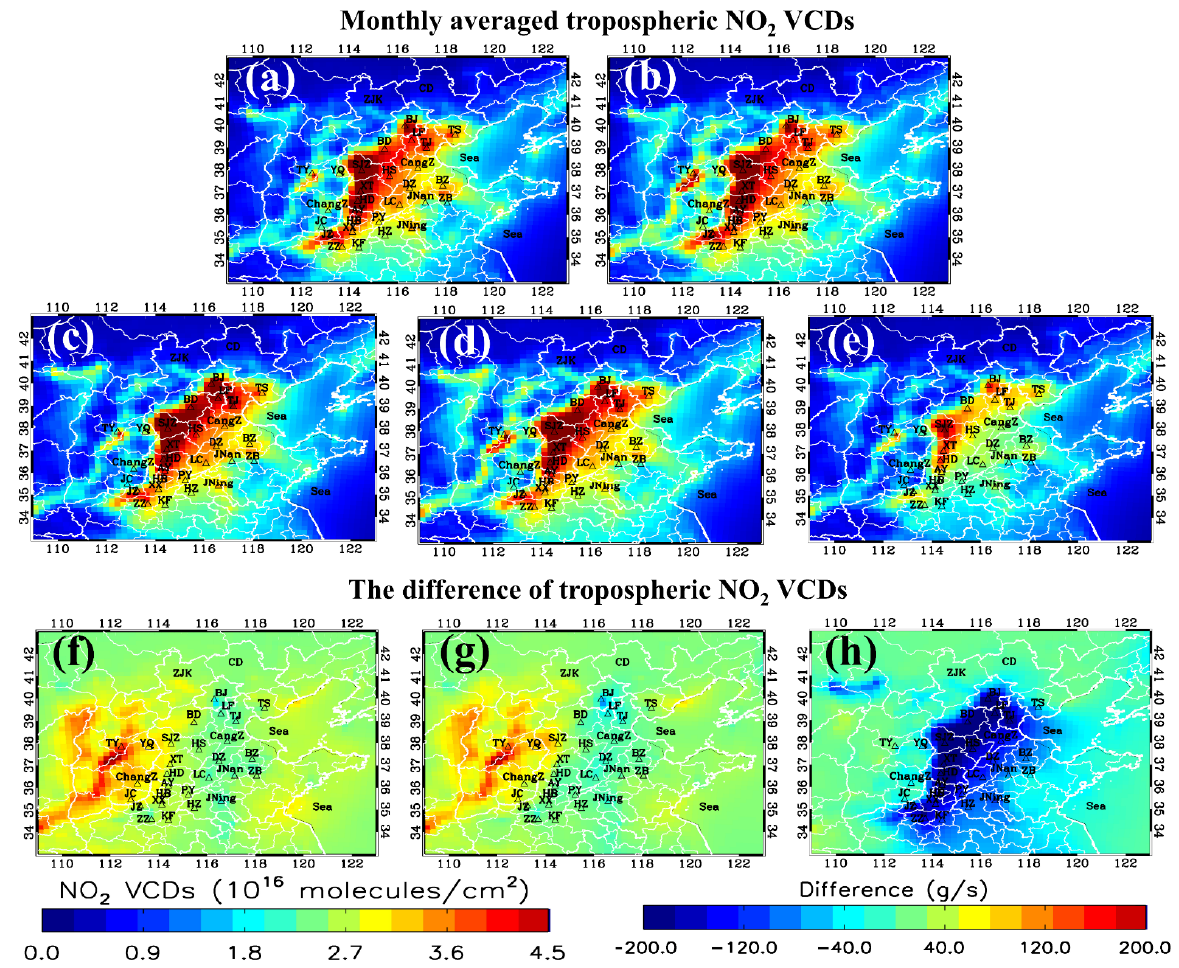
Figure 3. Four-month averaged tropospheric NO 2 VCDs simulated from MEIC-2017, top-down NO X emissions, and their differences. ( a ) Simulated NO 2 VCDs in W_2018 with MEIC-2017 inventory. ( b ) Same as ( a ) except with top-down W_2018 inventory. ( c ) Simulated NO 2 VCDs in W_2019 with MEIC-2017 inventory. ( d ) Same as ( c ) except with top-down W_2018 inventory. ( e ) Same as ( c ) except with top-down W_2019 inventory. ( f ) Difference between ( a ) and ( b ) (( b ) minus ( a )). ( g ) Difference between ( c ) and ( d ) (( d ) minus ( c )). ( h ) Difference between ( c ) and ( e ) (( e ) minus ( c )).